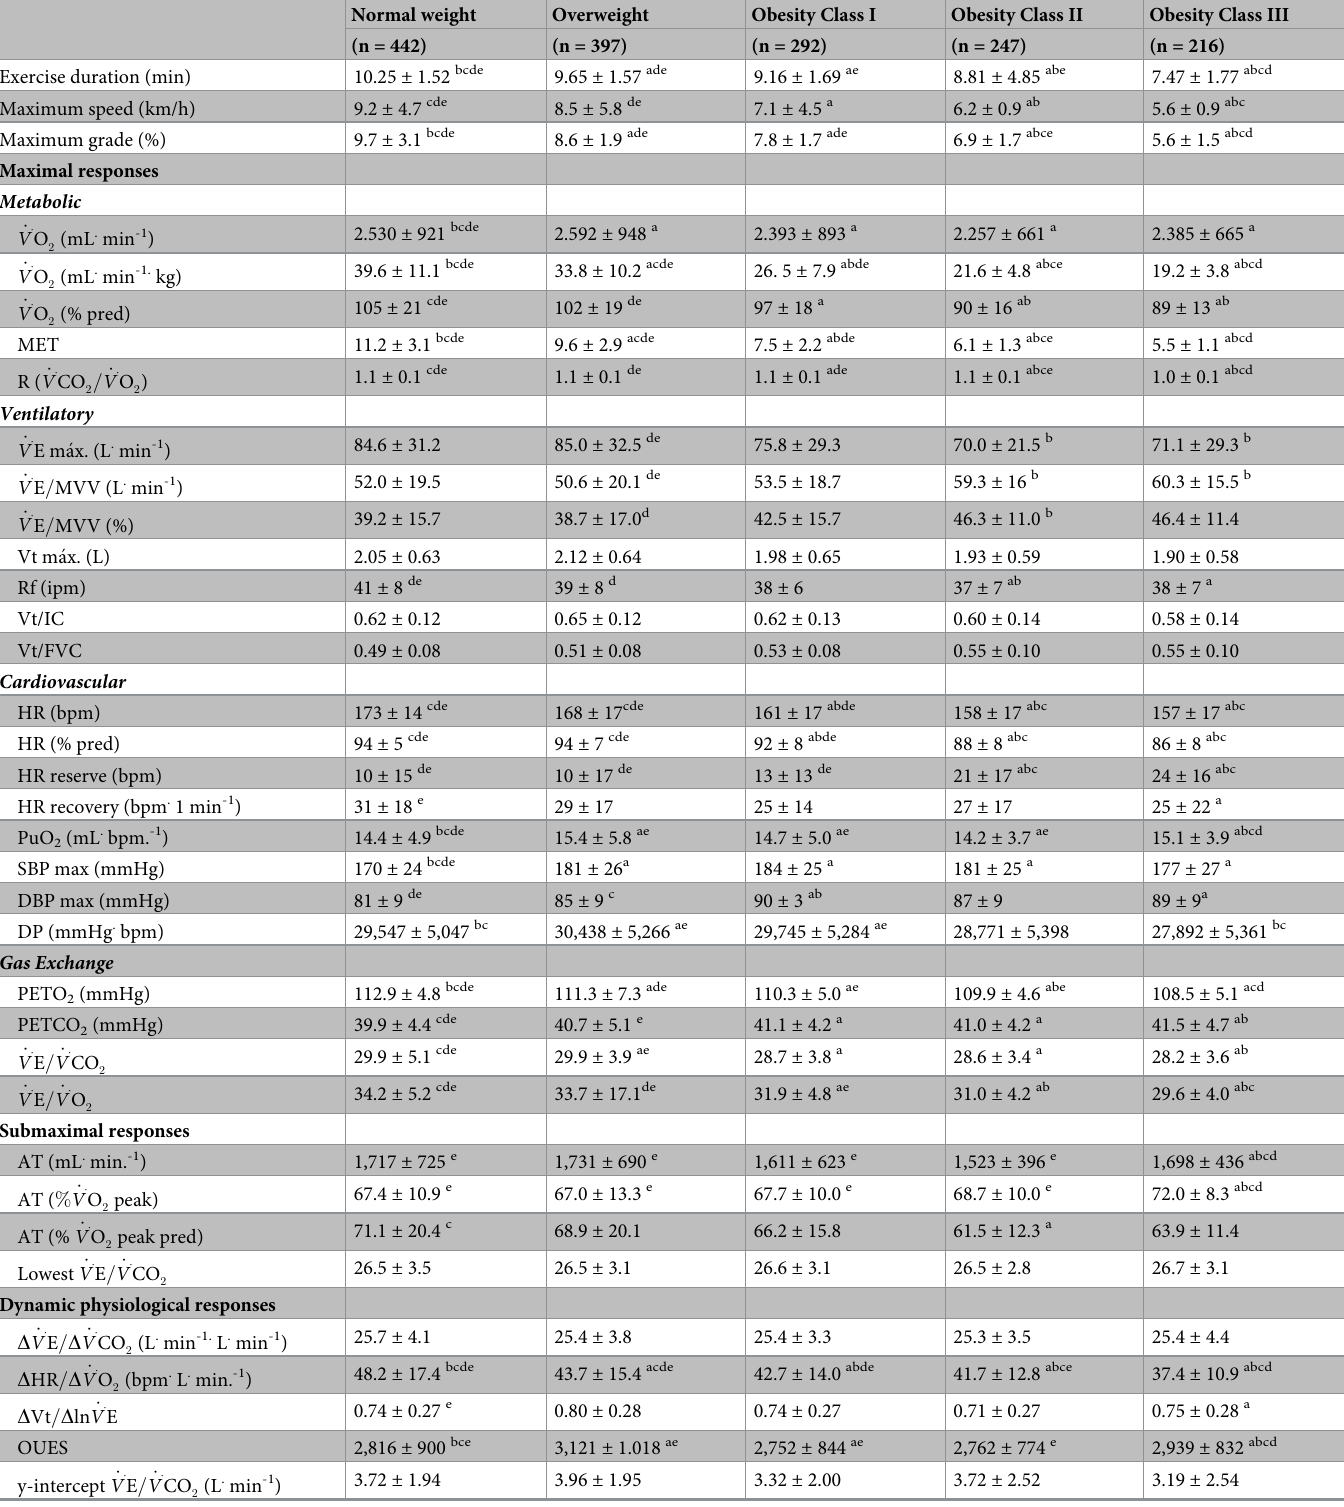
Table 3. According to normal weight, overweight and obesity groups (n = 1,594), physiological responses to cardiopulmonary exercise testing. Normal